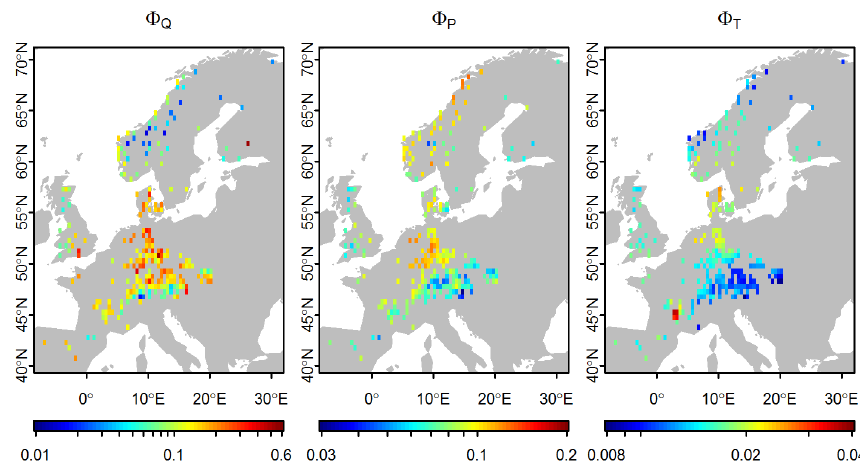
Fig. 3. Spatial patterns of the fraction of low-frequency variance of runoff ( 8 Q ), precipitation ( 8 P ) and temperature ( 8 T ). (Note that each panel has its own logarithmic colour